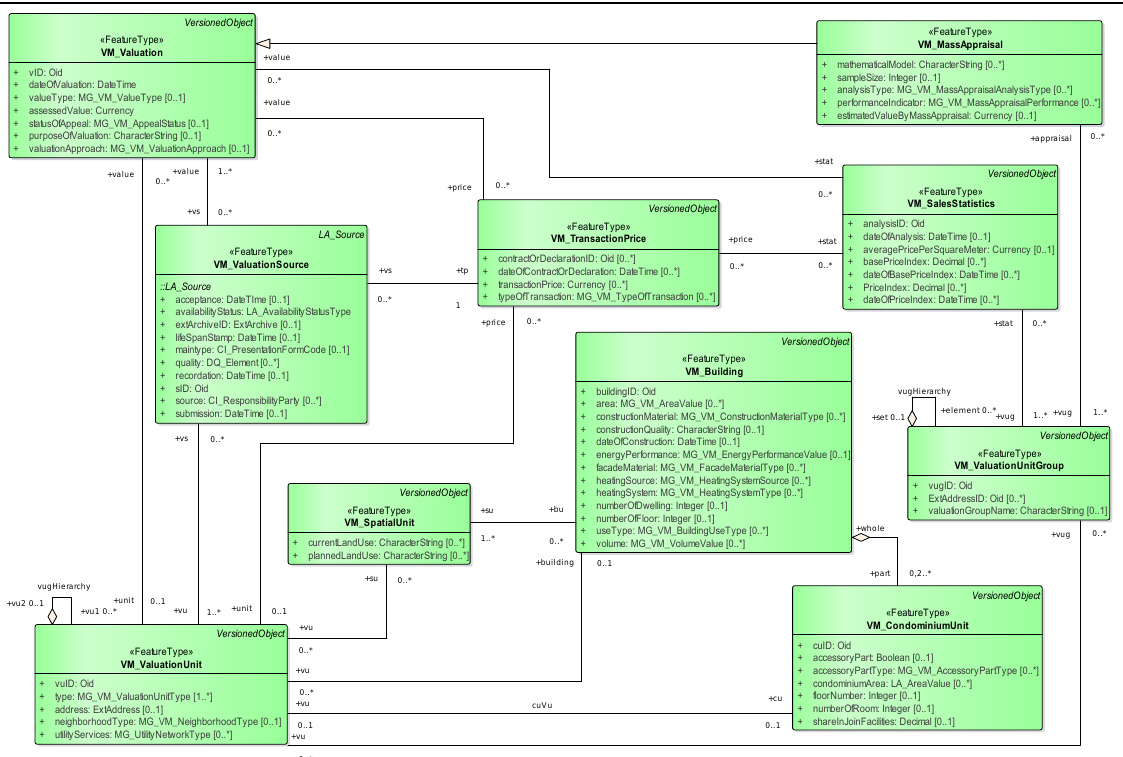
Figure 5. LADM Valuation Information Model.